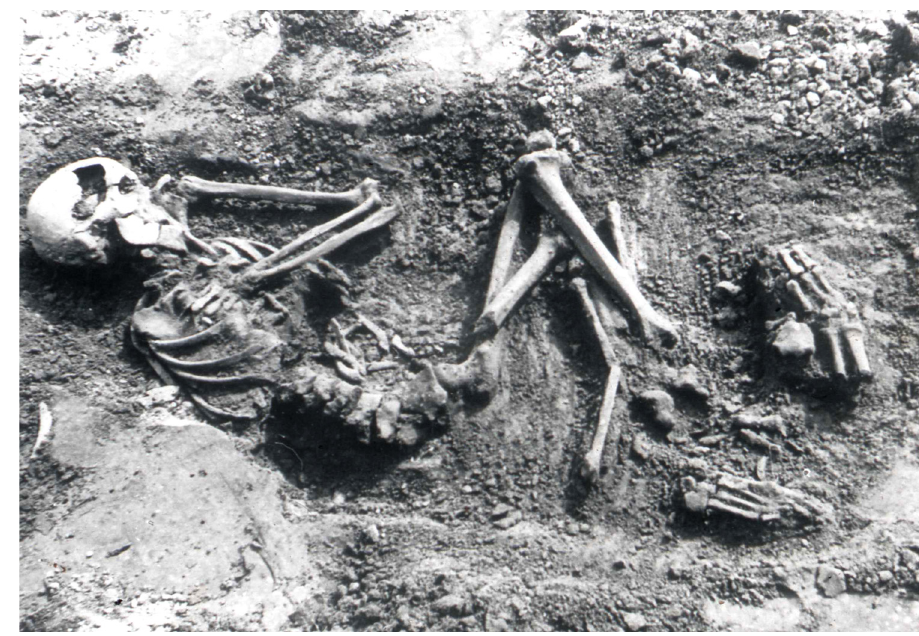
Figure 3: Burial 228 during excavation in 1956.